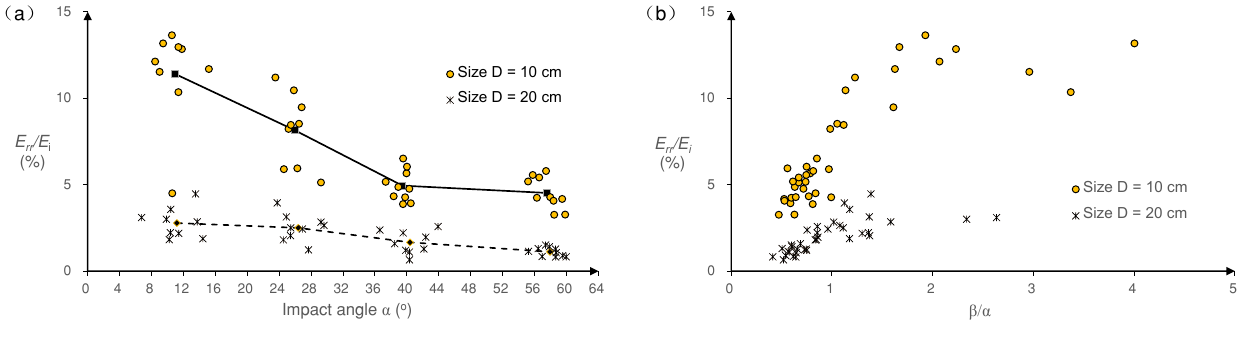
D = 10 cm are always more scattered than size D = 20